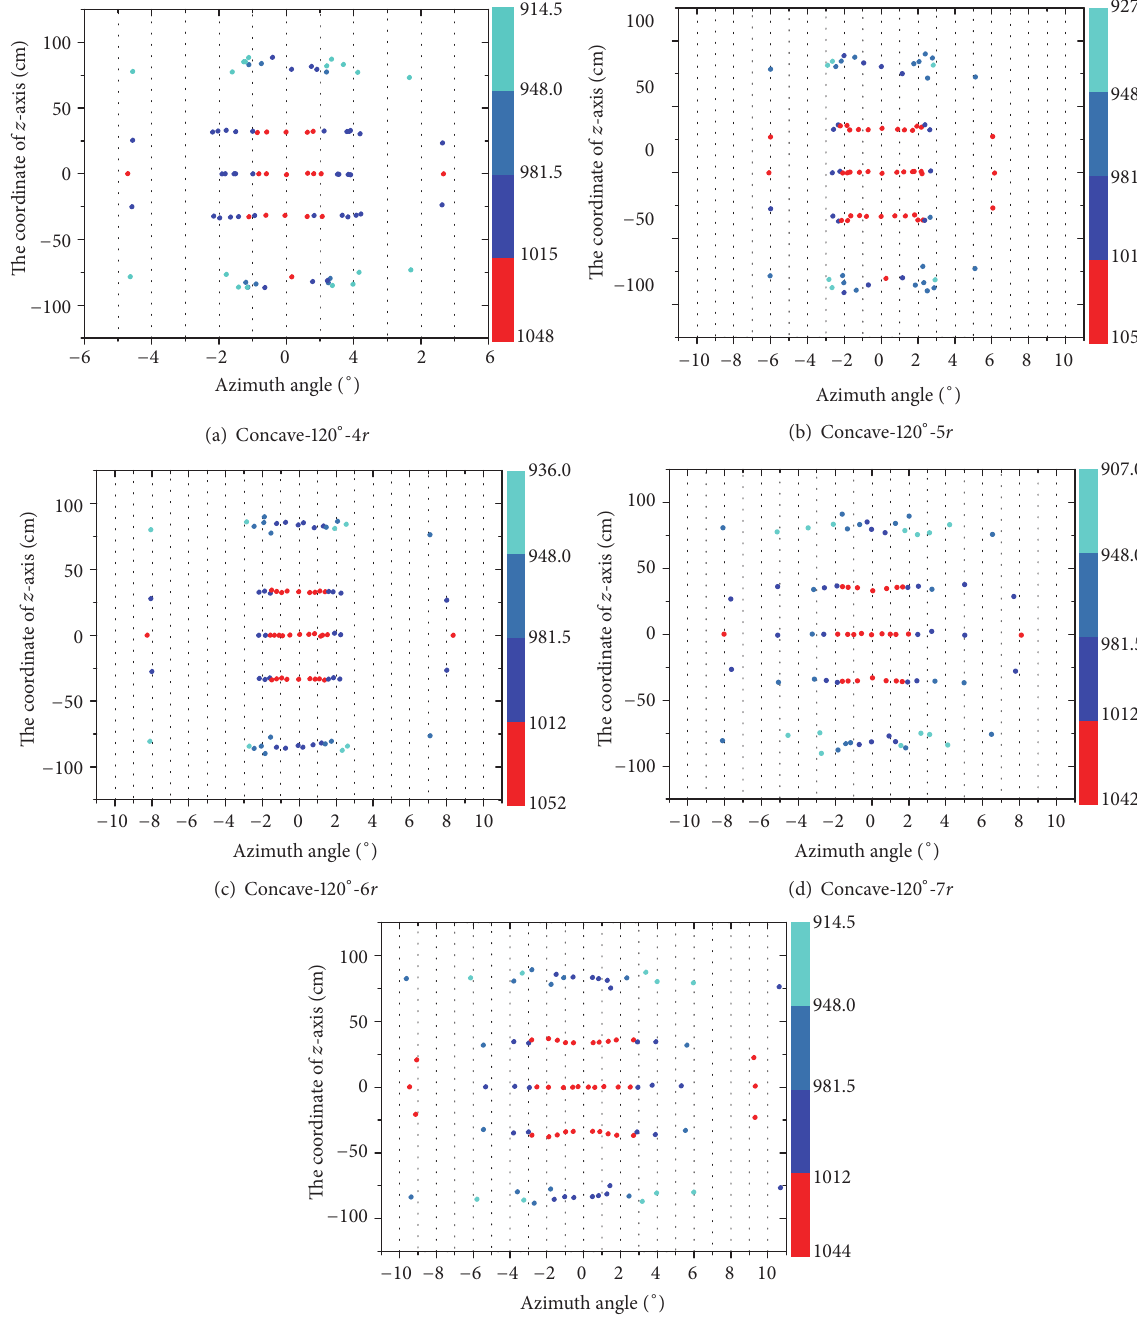
Figure 11: The spatial distributions of fragment corresponding to concave